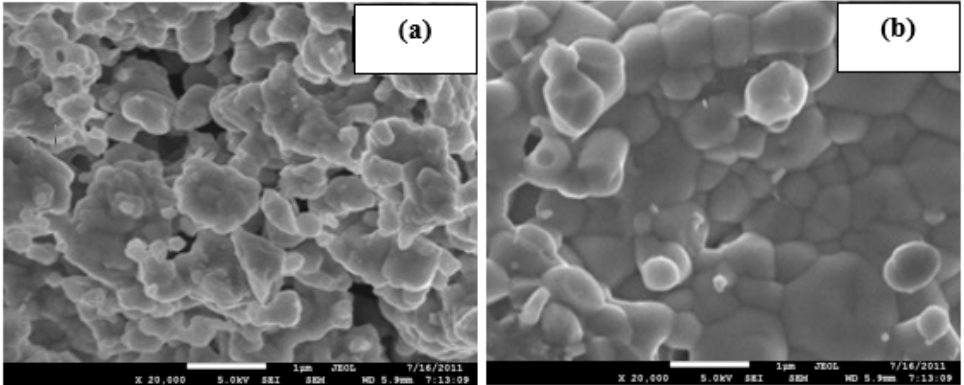
Figure 6. FESEM micrograph of the Li 1.4 Al 0.4 Ti 0.4 Sn 1.2 P 3 O 12 (x =0.4) sintered at ( a ) 750 °C and ( b ) 950 °C.